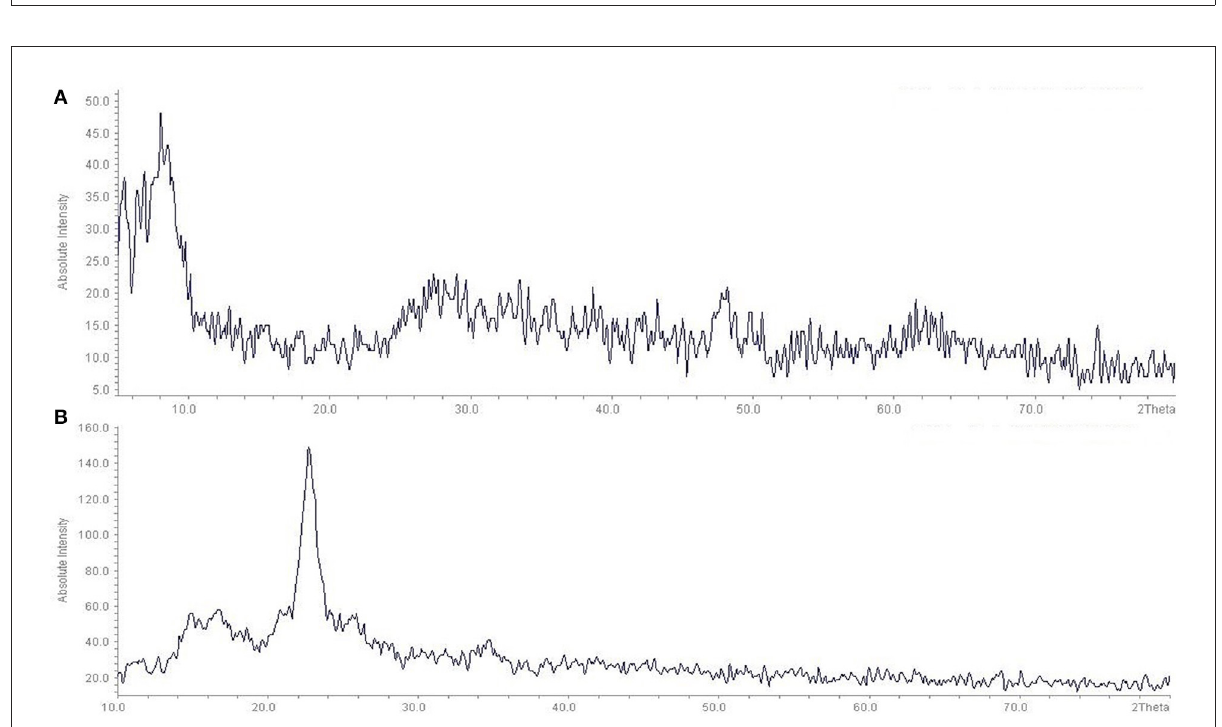
FIGURE3 XRD patterns of pure TiO 2 Nanopowder and fabric coated with TiO 2 nanoparticles: (A) Pure TiO 2 Nanopowder, (B) fabric coated with TiO 2 nanoparticles.